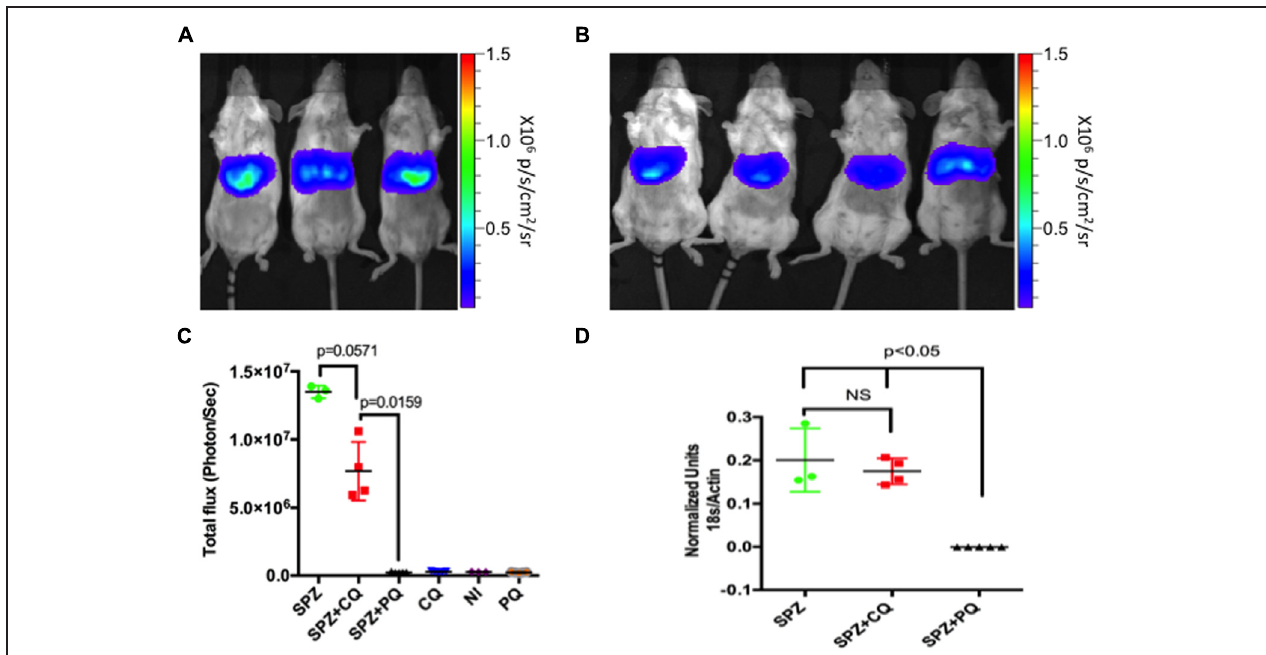
FIGURE 2 | Effect of CQ on LS parasite at 40 hours post infection (hpi). Rainbow images of mice infected and untreated (A) or CQ-treated (B) showing parasite load in liver 40 h after injection of 1.5 × 10 4 Py -Luc salivary gland SPZ. Rainbow scale represents radiance (p/s/cm 2 /sr). (C) Quantification of total flux from whole body imaging of mice (shown in A and Supplementary Figure S1). n = 3 for SPZ ( infected and untreated) and NI (neither infected nor treated) group, four for SPZ + CQ group and